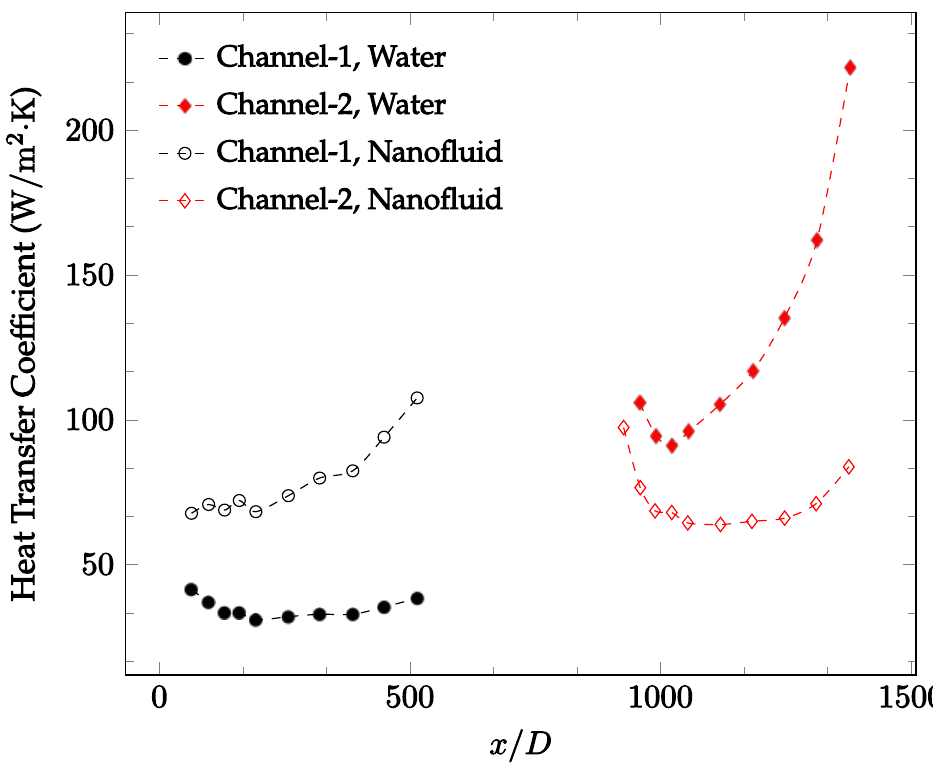
Figure 20. Change in convective heat transfer coefficient of deionized water and Fe 3 O 4 -deionized water nanofluids as a function of dimensionless distance for a Reynolds number of 20–25. The nanoparticle concentration was 1% by weight. A converging nozzle is used as a connector.